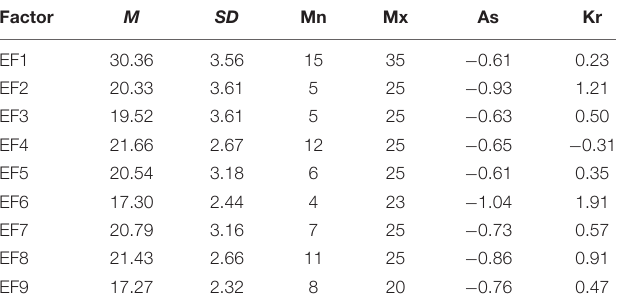
TABLE 3 | Scale factors’ descriptive statistics.